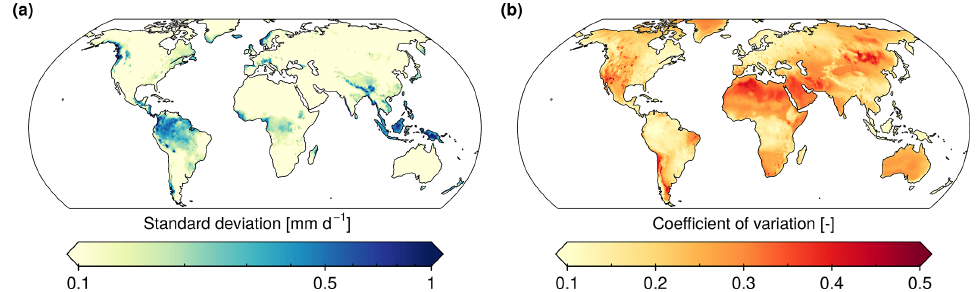
Figure 7. Long-term mean of the monthly standard deviation of the runoff reconstruction ensemble (a) and the corresponding coefficient of variation (b)